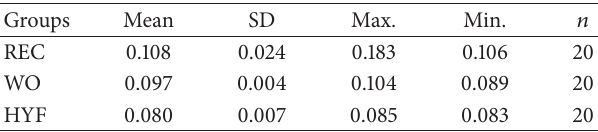
Table 1: Mean, maximum (max.) and minimum (min.) extrusion quantity (grams), standard deviation (SD), and number of teeth per group ( 𝑛